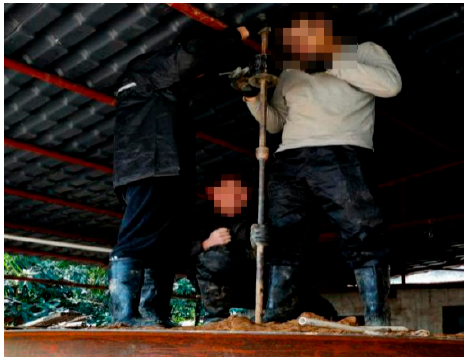
Figure 6. Light dynamic preliminary detector.